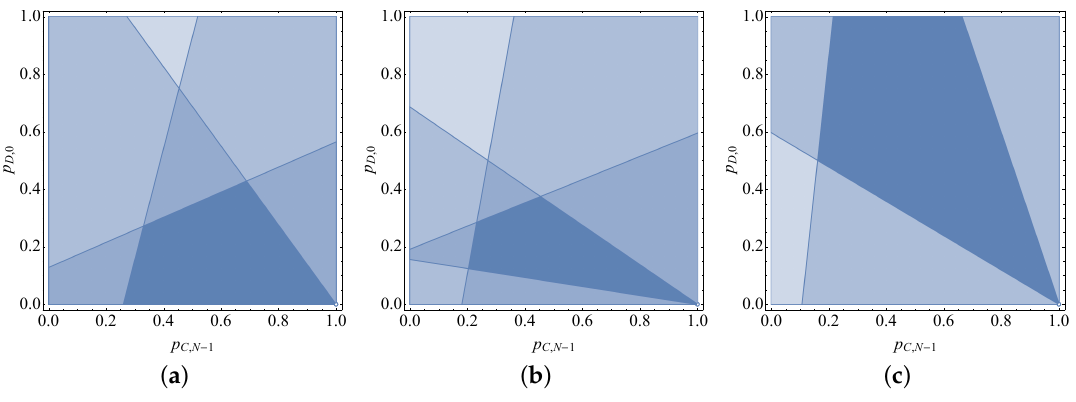
< r < N + β ; ( b ) Case 2: N ; N − 1 N − 1 N − 1